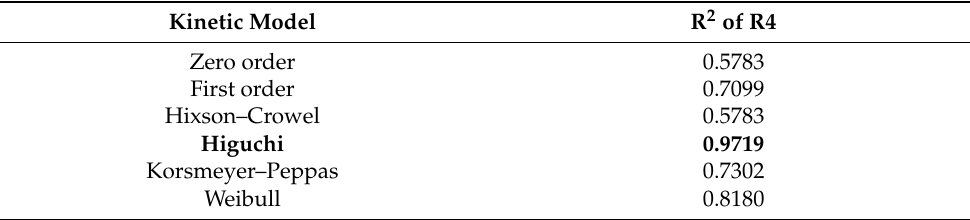
Table 2. Values of the coefficients of determination obtained for all the kinetic models used.